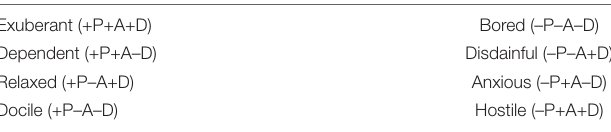
TABLE 1 | Emotions in the three-dimensional Pleasure-Arousal-Dominance (PAD) space 1 . Exuberant